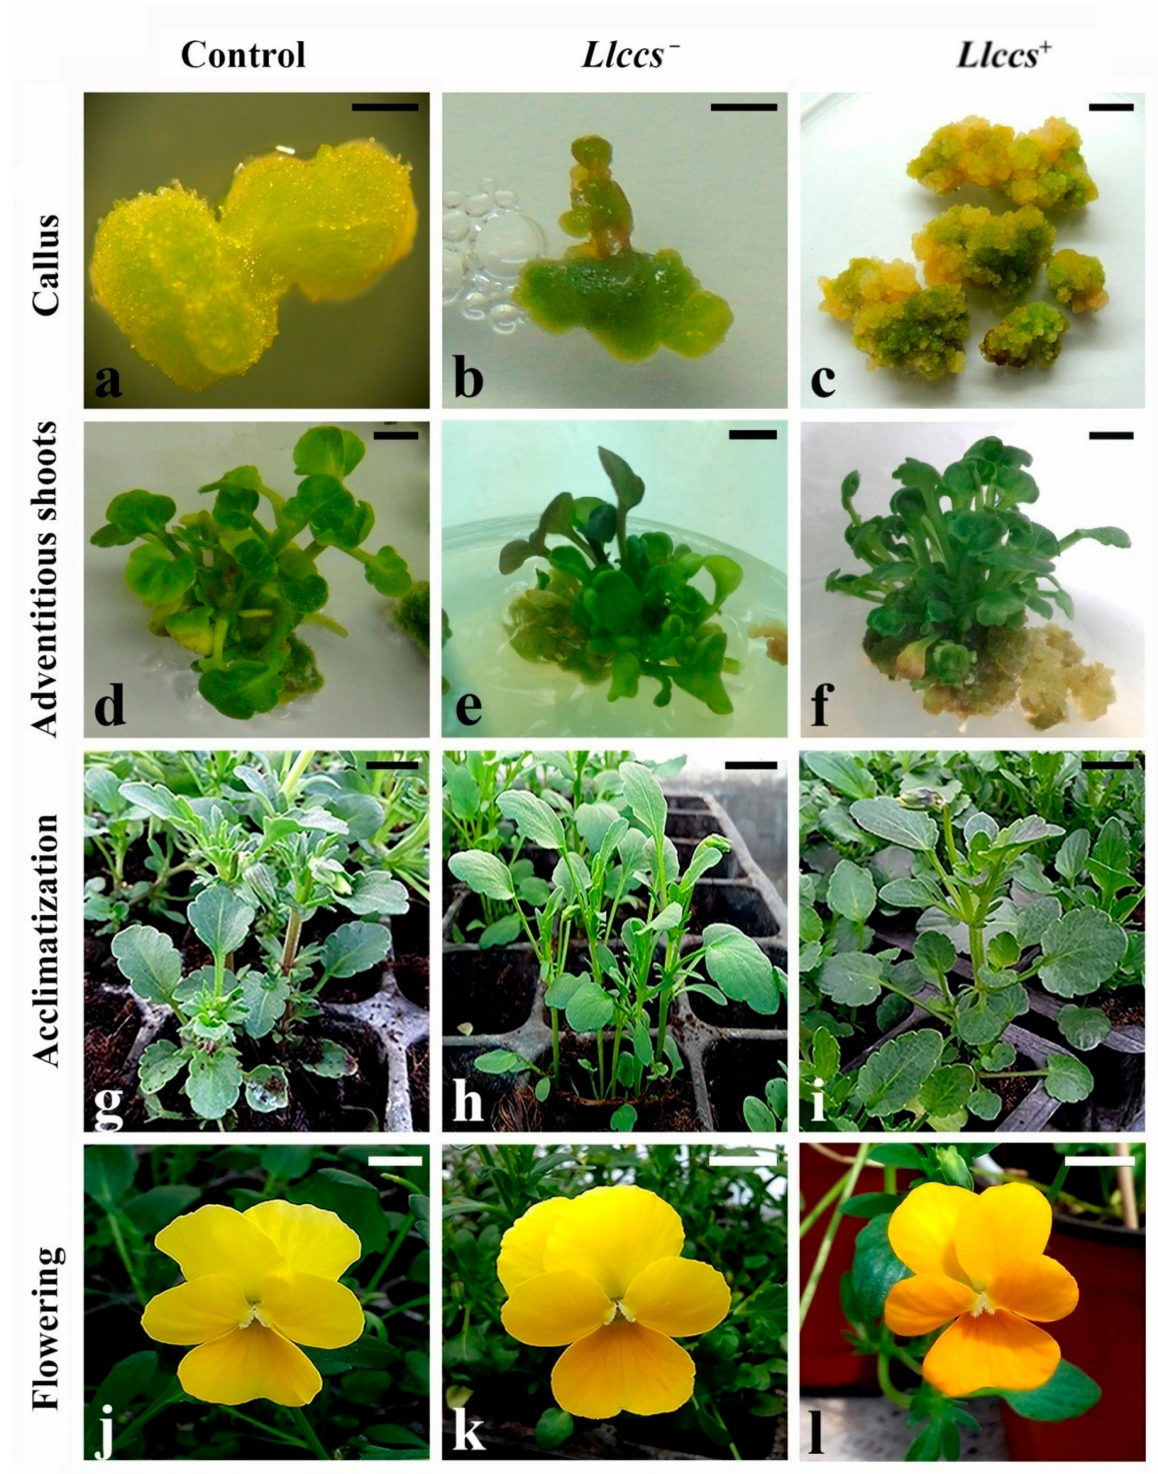
Figure 3. Plant regeneration of Viola cornuta cv. “Lutea Splendens”. ( a – c ) Callus formation on hypocotyl explants; ( d – f ) Shoot cultures of control and transgenic plants regenerated two months after genetic transformation; ( g – i ) Acclimatization of regenerated plants; ( j – l ) Flowering of regenerated control and transgenic plants. Bars: ( a , b ), 1 mm; ( c ), 5 mm, ( d – l ), 10